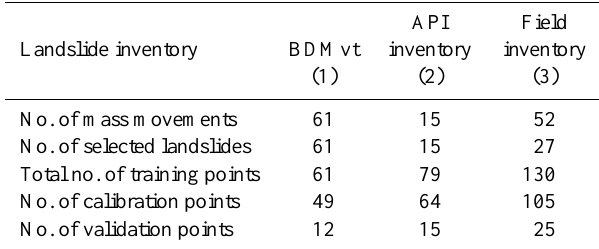
Table 3. Summary of the characteristics of the landslide databases used for the susceptibility